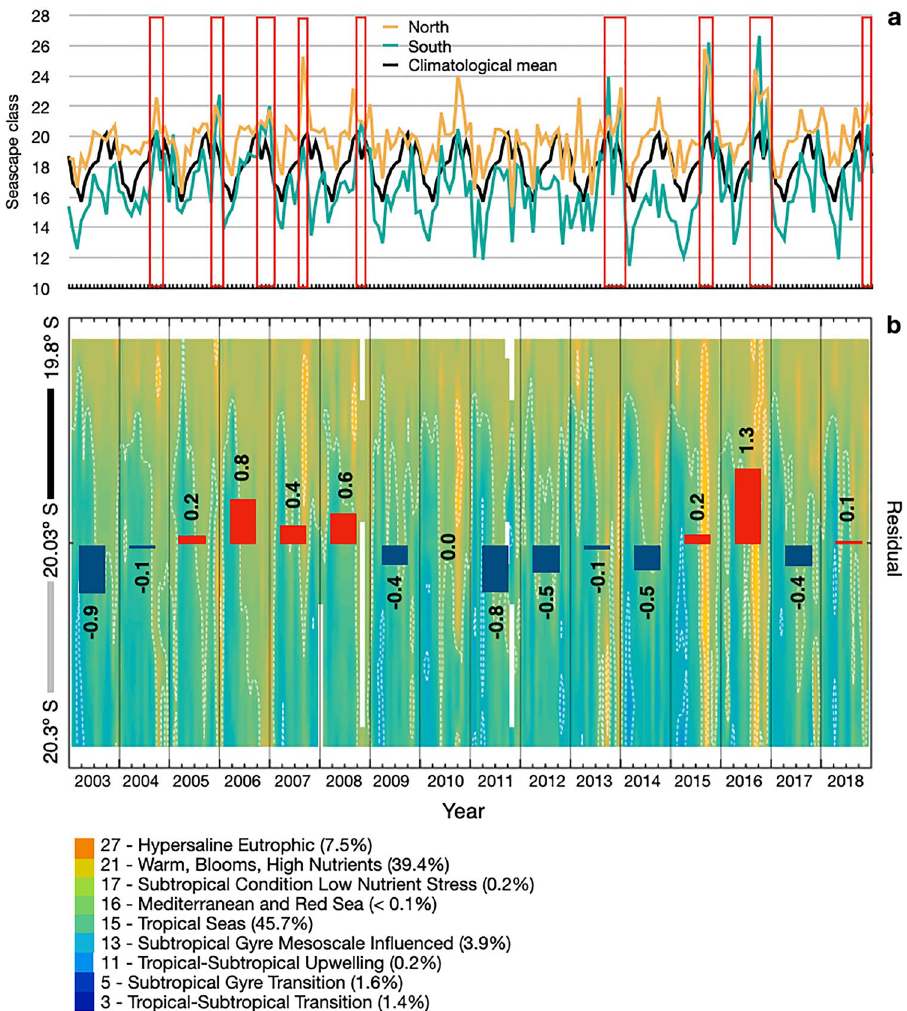
Figure 4. Monthly variations in Seascape classes in the study site (local scale ~ 30 km coastline, 465 km 2 ) during 16 years before the recruitment samplings (January 2003 to December 2018). Differences in mean Seascape conditions were compared between the northern and southern areas of the study site, which exhibited distinct Seascape patterns during recruitment samplings (upper graph, ( a ), assessing the contribution of each Seascape class to the mean latitudinal variation (lower graph, ( b ), and quantifying the variation from the climatological mean (lower graph, b ). Potential periods of reduced recruitment, when regional Seascapes are mostly dominated by warm high nutrient pelagic conditions, are highlighted (red squares; a , b ). Note: line plots represent mean Seascape classes (upper graph, a ); bars represent Seascape class residuals (lower graph, b